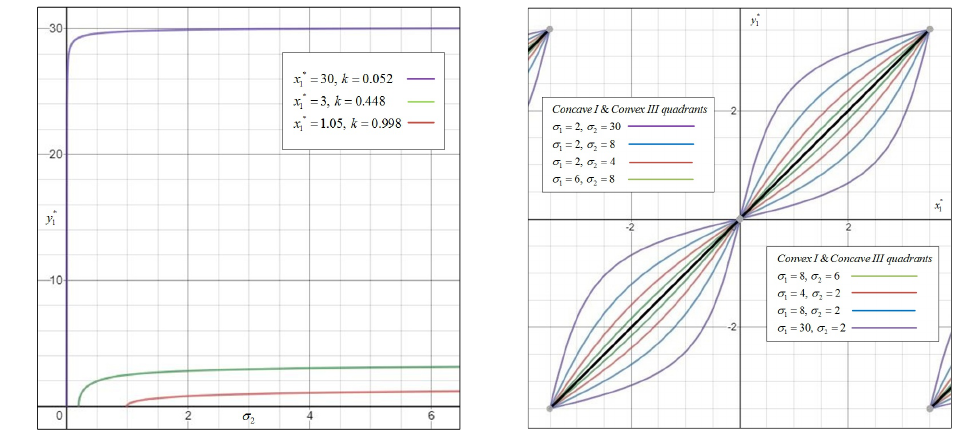
( x ∗ ): Black line σ 1 = σ 2 . Concave 1 1